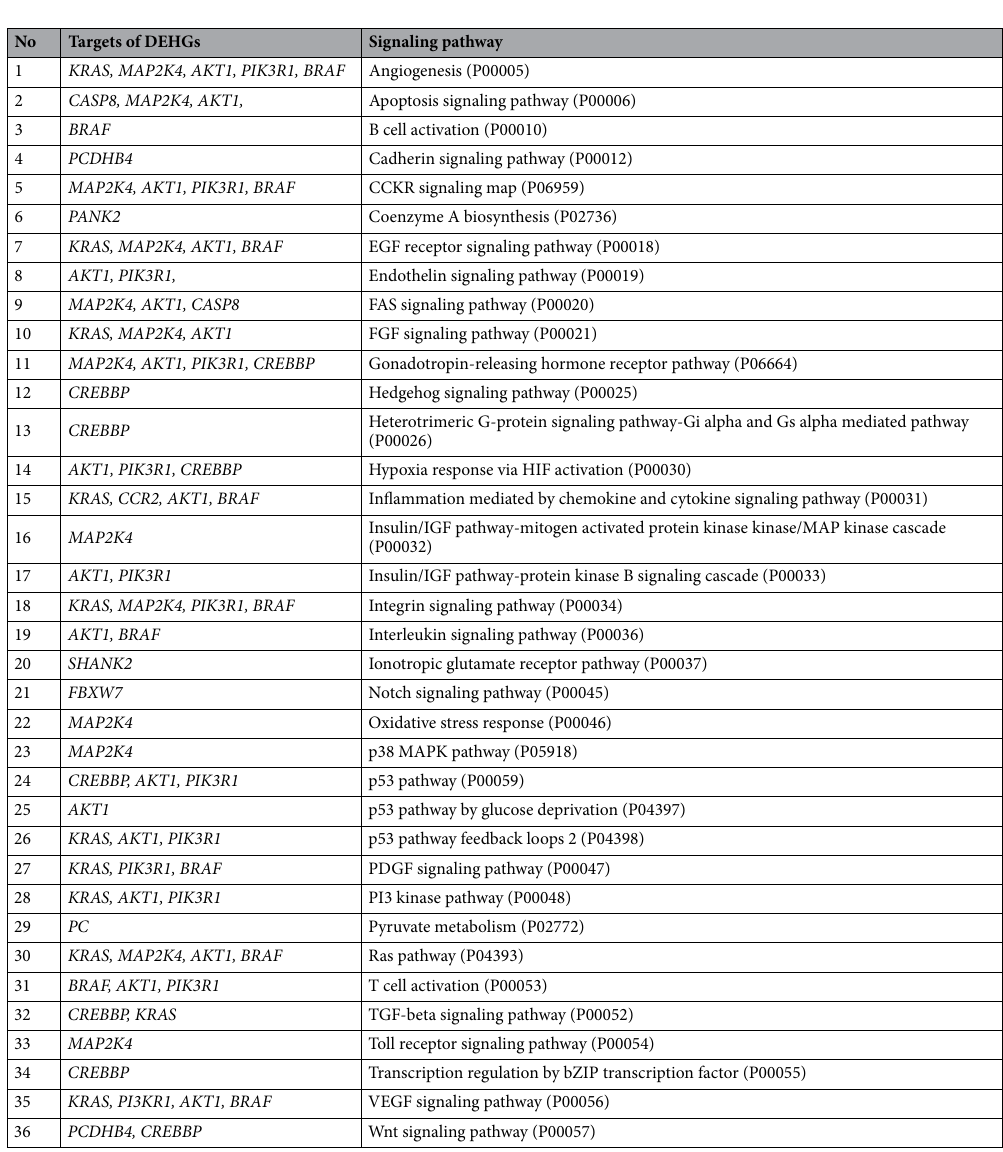
Table 3. Target genes of the differentially expressed HOX genes in HNSCC determining the oncogenic signaling